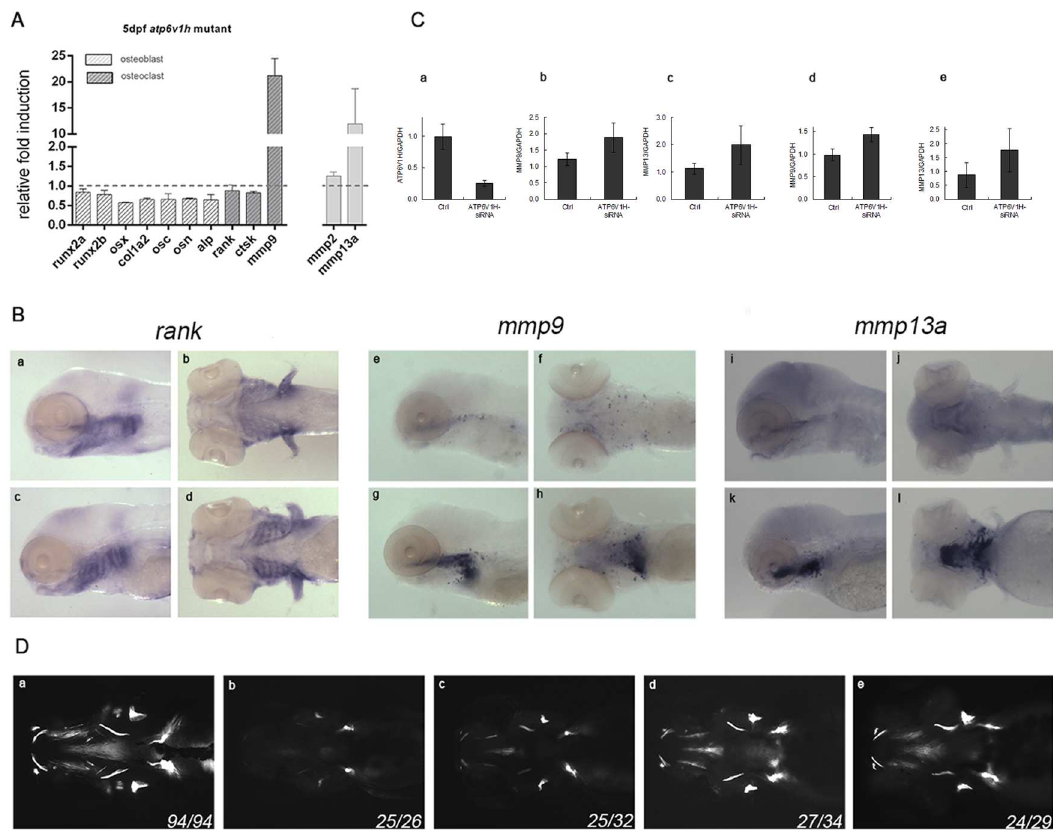
Fig 4. Induction of mmp9/mmp13 and rescue of atp6v1h-deficient phenotype. In ( A ), qPCR analysisof designated marker genesshowingsignificantinductionof mmp9 and mmp13 mRNA expressionin atp6v1h mutant. Analysis of osteoclast cells by RNA wholemount in situ hybridization. atp6v1h mutant embryos showing significantincreasesof mmp9 and mmp13a signalsin embryonic head skeleton(e/f/i/j wild type, g/h/k/l mutant), but osteoclast marker rank pattern is not changed(a/b wild type, c/d mutant) ( B ). In ( C ), analysisof Mmp9/Mmp13 expressionin mouse osteoclast Raw264.7 cells after knockdown of Atp6v1h by siRNA is shown. When Atp6v1h expressionwas knocked down by siRNA (a), the expressionof Mmp9 (b) and Mmp13 (c) were induced. Similarly, the inductionof Mmp9 (d) and Mmp13 (e) was also observed in RANKL-induceddifferentiatedmouse osteoclast Raw264.7cells. In ( D ), MMP inhibitionrescues the bone phenotypein Atp16V1h mutant fish as detected by calceinstaining;a, wild type, 0.5% DMSO; b, mutant, 0.5% DMSO; c, mutant treated with 200uMMMP9 inhibitorII in 0.5% DMSO; d, mutant treated with 20uM MMP13 inhibitorin 0.5% DMSO; e, mutant treated with 50uM MMP9/13 inhibitorI in 0.5% DMSO. Images are ventral views of 6 dpf